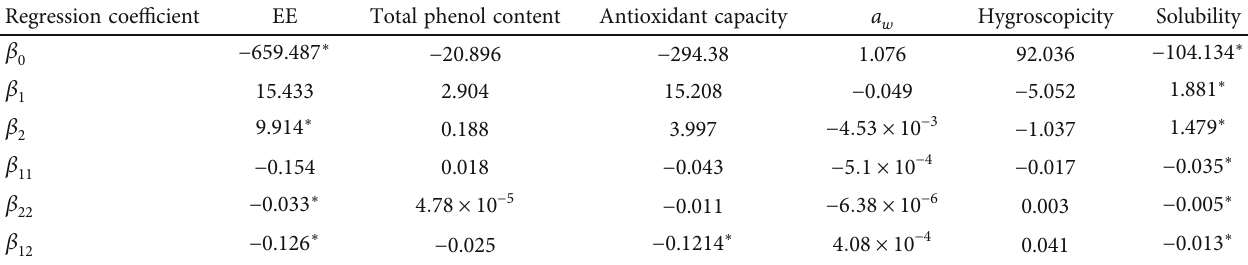
Table 4: Estimates of the regression coe ffi cients of the second-order polynomial of the CCR design for each response. Regression coe ffi